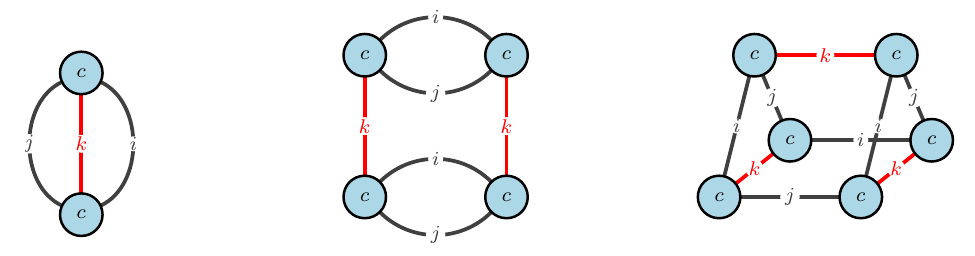
Figure 1 . Theta, tincan and prism diagrams. All diagrams are trivalent networks without any loop, and vertices are the structure constants c k . Each vertex has indices i, j, k which are paired with ij their counterpart in another vertex. This pairing is done using g along edge of type k (colored red) and g − 1 for type i and j . Tincan and prism are given with some sample labeling. Red lines are labelled by g and black lines by g − 1